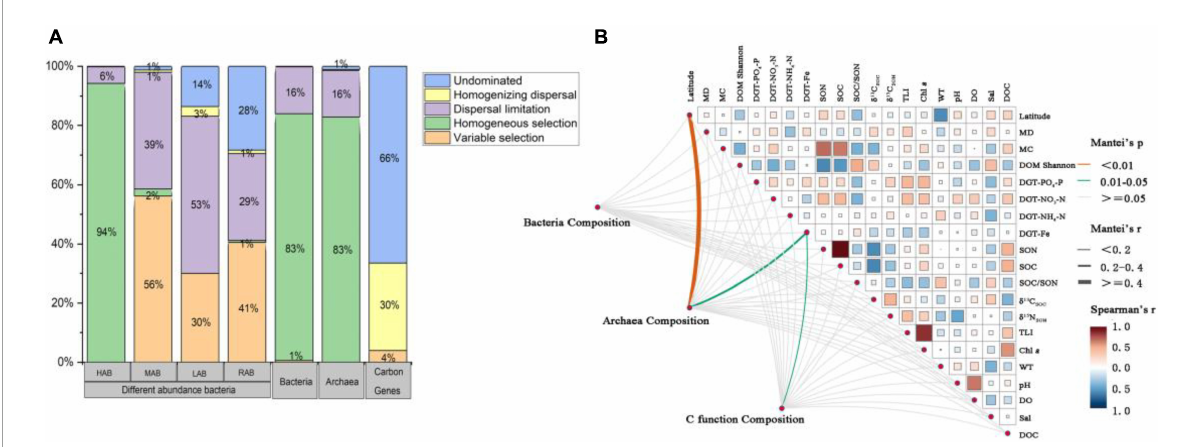
FIGURE6 The assembly process of microbial communities and carbon-functional genes (A) and their relationship with environmental factors (B) . Pairwise comparisons of physicochemical factors are displayed with a color gradient to denote Spearman’s correlation coefficients. Community composition is related to each environmental factor by performing a Mantel test. The relevant abbreviations are referred to the text and Table 1 .